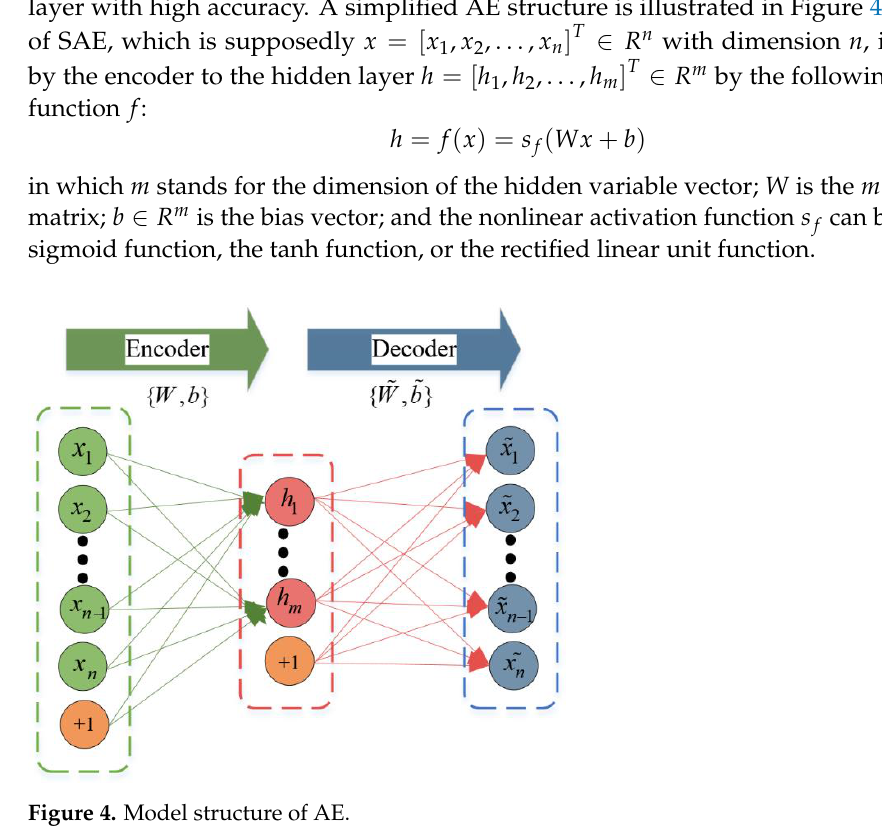
Figure 4. Model structure of AE.